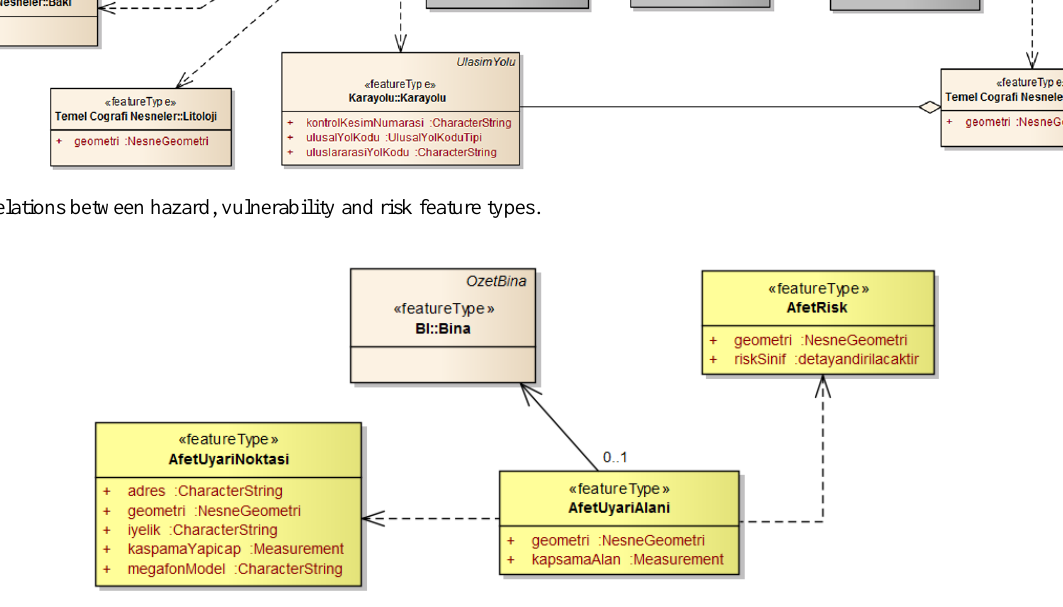
is associated with a landslide hazard when landslide hazard is in vulnerability feature